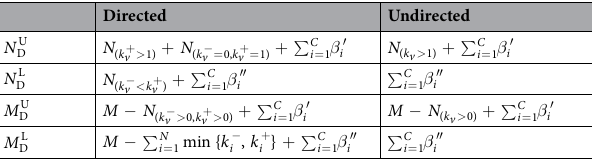
their + k and − k for the lower (structural switching matrix) and the upper (unweighted switching matrix) bounds. v v